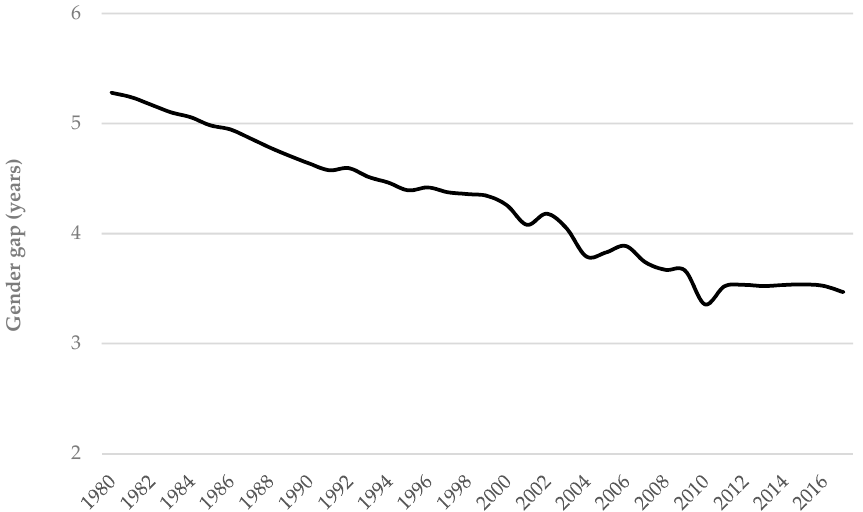
Figure 2. Gender gap (males—females) in the mean age at marriage (years) in Greece, 1980–2017. Variability in the gender age gap at marriage reduced between 1980 (coefficient of variation across Greek prefectures: 17.1%) and 2017 (14.9%). The corresponding value of gender age gap for marriages celebrated outside Greece by at least one non-resident spouse with Greek citizenship was lower for both 1980 and 2017. At the beginning of the study period, gender age gap was particularly high